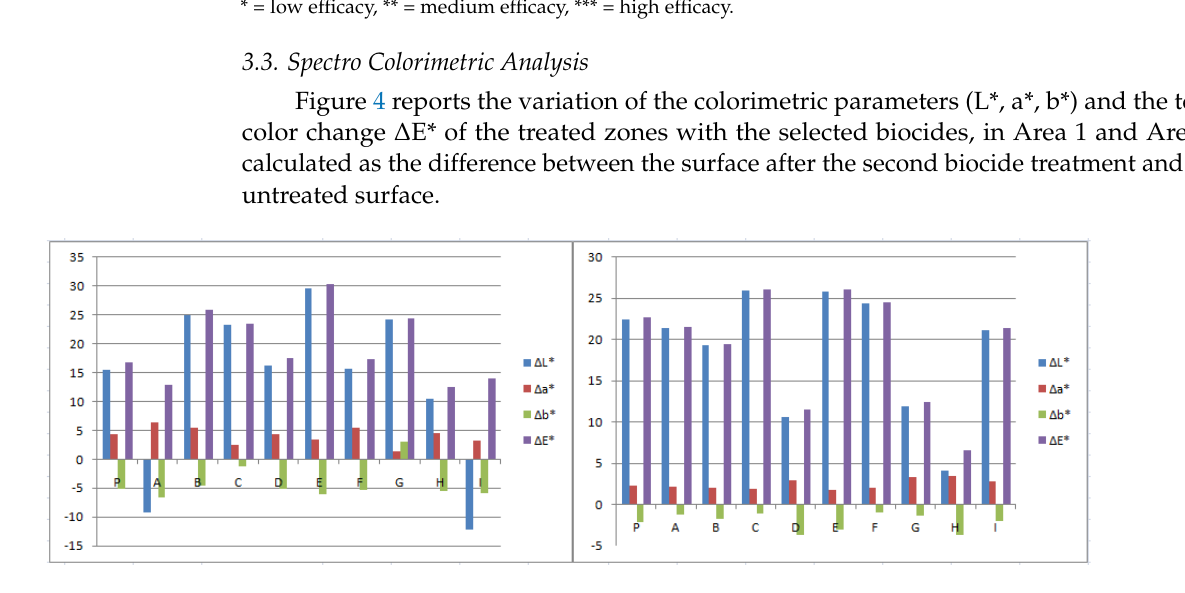
Figure 4. Histograms of the chromatic parameters (ΔL*, Δa*, Δb*, and ΔE*) for each treated zone of Area 1 ( left ) and Area 2 ( right ). Standard deviation is about 0.75 < SD > 2.90. The average values of the chromatic parameters L*, a*, b*, before the treatment, in Area 1, were L* 36.81, a* −0.89, and b* 16.71 while in Area 2, the average values correspond to L* 44.41, a* −0.28, and b* 15.07. These data are taken as a reference to see if the